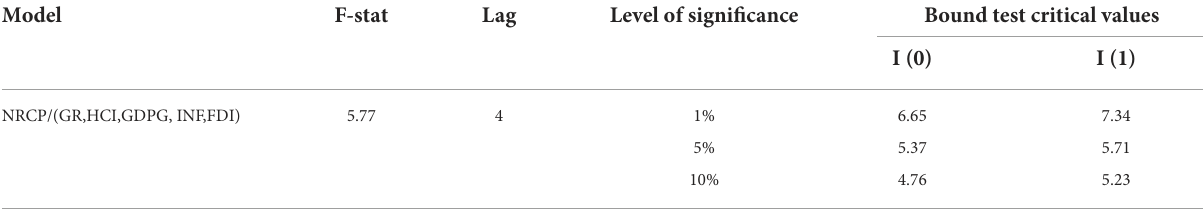
TABLE 6 ARDL bound test.